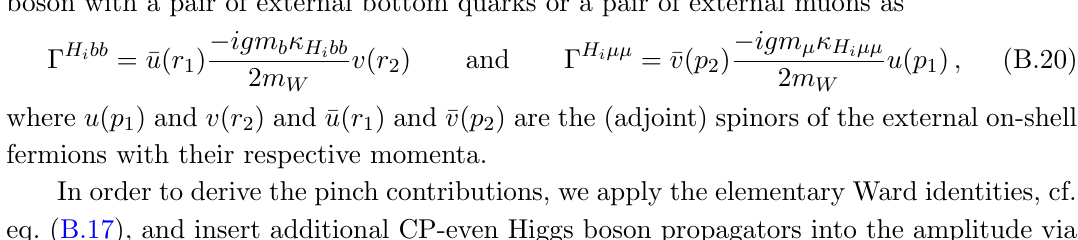
Figure 16 . All generic Feynman diagrams contributing to the CP-even pinched self-energies. boson with a pair of external bottom quarks or a pair of external muons